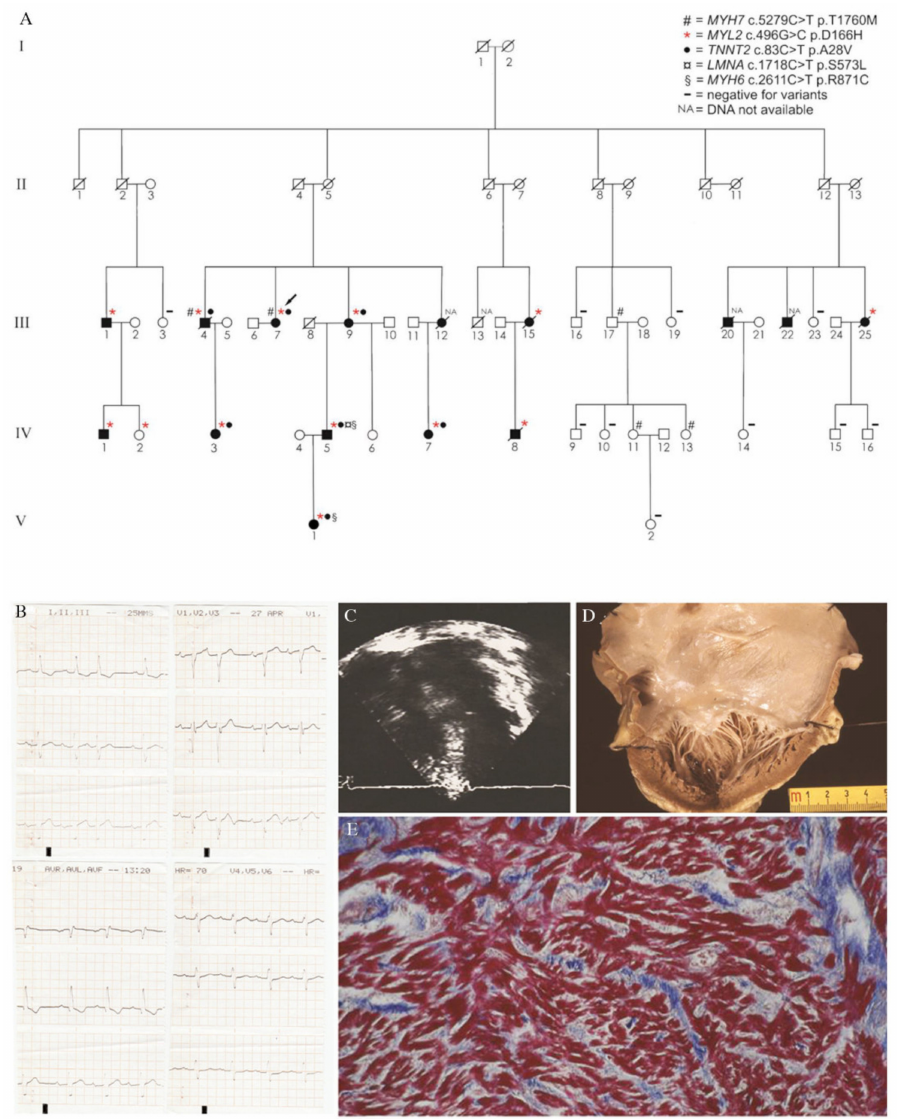
Figure 2. Novel Missense variant in MYL2 gene and hypertrophic cardiomyopathy associated with a high incidence of restrictive physiology. ( A ) Pedigree of the family. ( B ) Electrocardiogram of